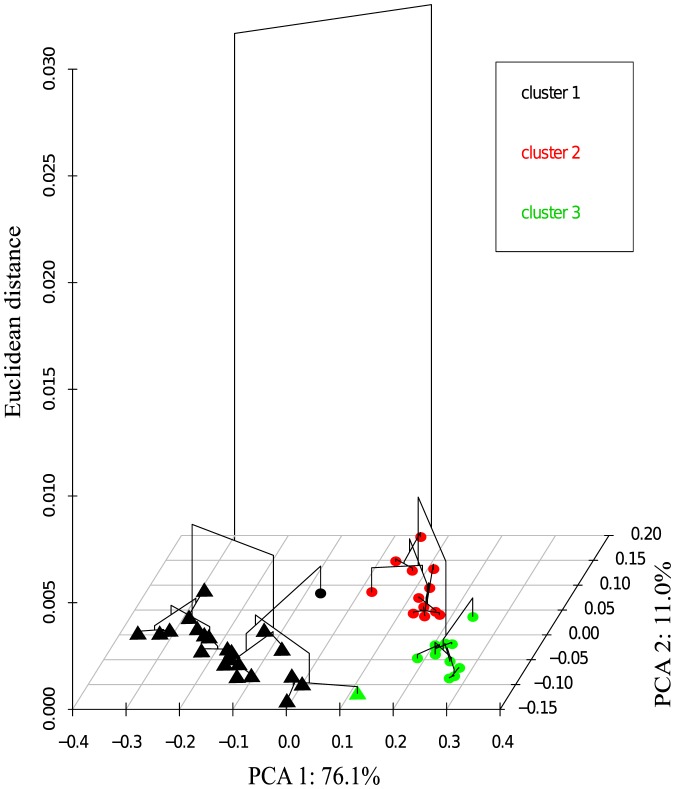
Hierarchical clusters of ice algae (triangles) and C. centralis (circles) fatty acid profiles overlaid on the first two principal component axes.